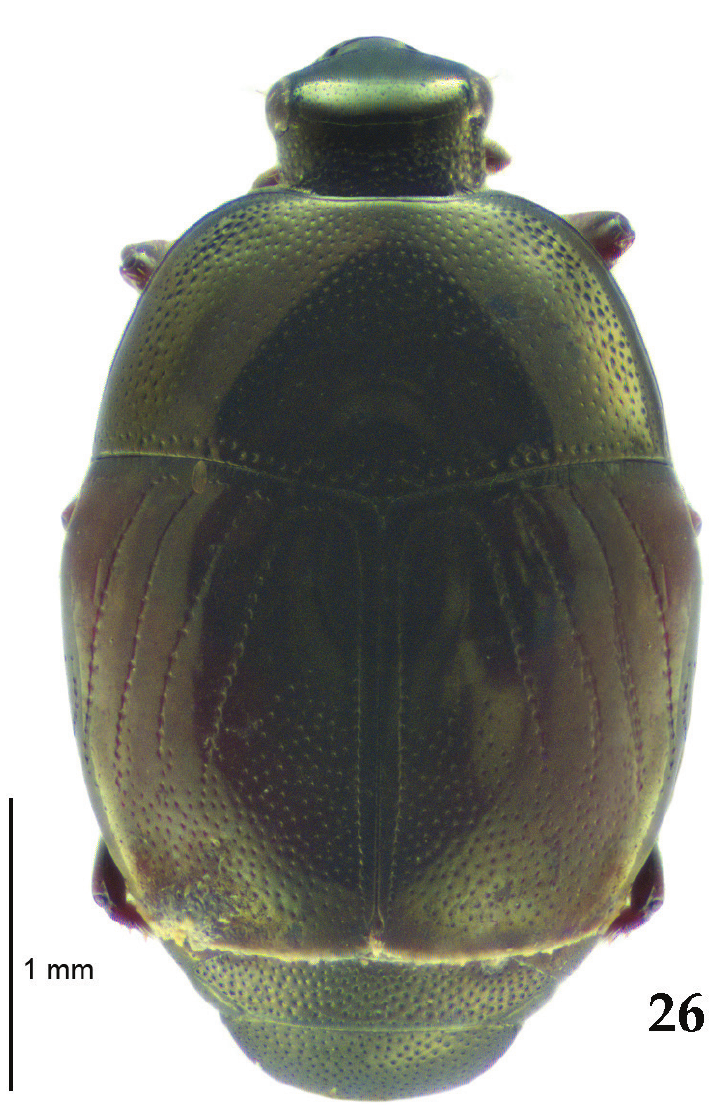
Figure 26. Chalcionellus aeneovirens (Schmidt, 1890) habitus, dorsal view. lowed by: “coll. Schmidt - / Bickhardt” (printed); followed by: “Type” (brick-red label, printed); followed by: aeneovi- / rens * J. Schmidt” (light blue label, written); followed by: “aeneovirens / J. Schmidt / H. Bickhardt det. 1919” (printed-written); followed by: “LECTOTYPUS / Chalcionellus / aeneovirens (Schmidt) / Gomy et Vienna des., 1999” (red label, printed) (ZMHUB). Paralectotype, ♀ , designated by Gomy & Vi- enna in 1999, right mesotarsus and left metatarsus broken off and glued onto the mounting card of the specimen together with the extracted female genitalia, with